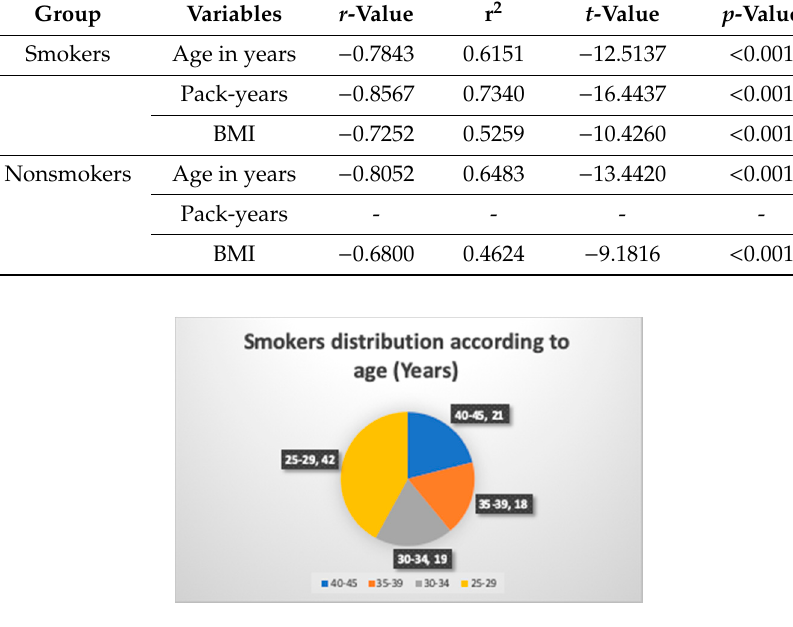
Figure 3. Age wise distribution of smokers.